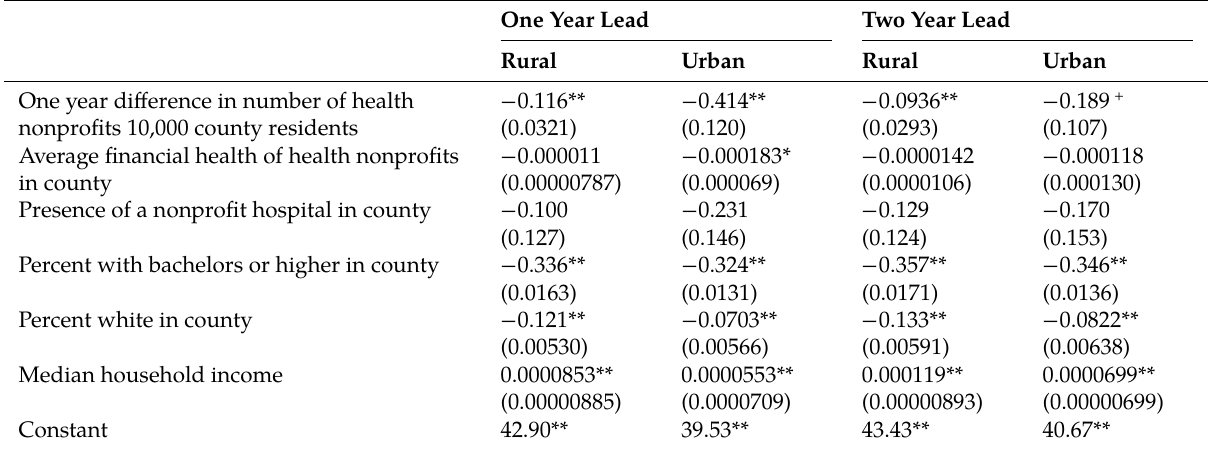
Table 2: Lead regression results on county obesity rates, 2004 –